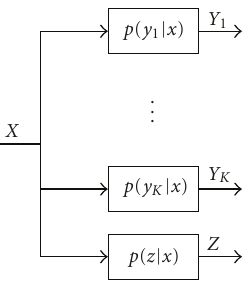
Figure 1: Secure broadcasting to many users in the presence of an